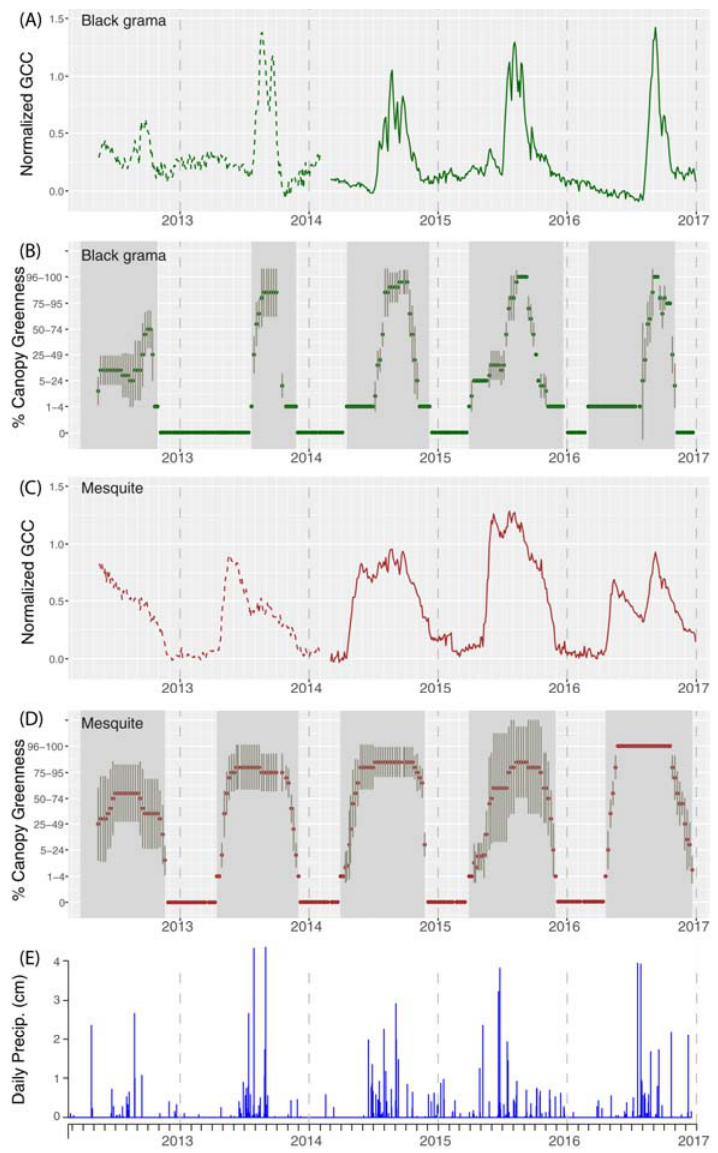
Figure 4. (( A )–( E )): Phenocam GCC for: black grama ( A ); and mesquite ( C ) ROIs; and mean field-estimated percent canopy greenness for: black grama ( B ); and mesquite ( D ), from 2012 to 2016. Standard deviation of mean canopy greenness is noted by vertical gray lines in ( B , D ). SOS and EOS are the left and right edges of the gray rectangles in ( B , D ). SOS in 2012 was estimated from weekly observations of condition that did include intensity metrics until May 2012. Daily precipitation (cm) is depicted ( E ).